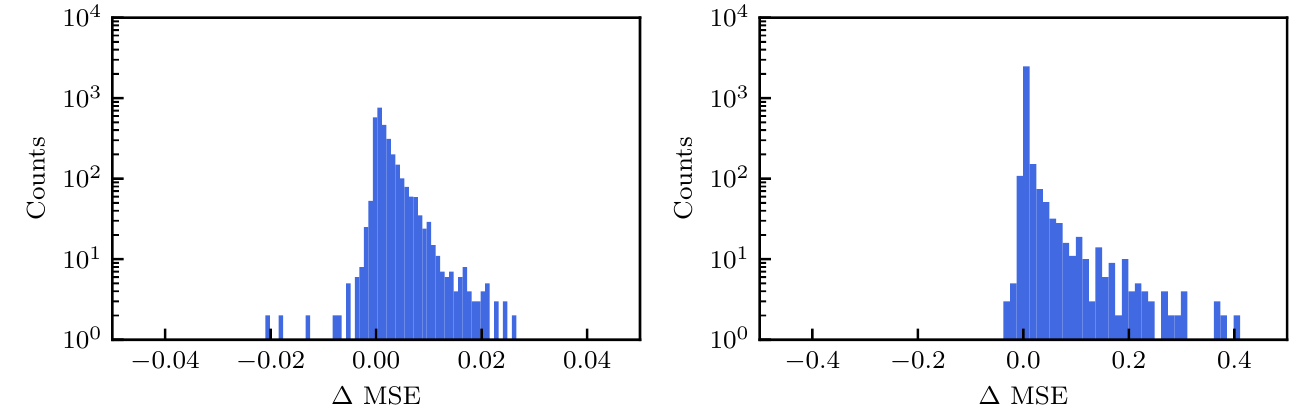
Figure 12. Left column: Distribution of the MSE for the fit of the DA model (14b) with three parameters (top), after applying a GP 50 times to the DA numerical data (middle), and difference of the MSE for the two approaches (bottom). Right column: Same, but for the model with two parameters. Note the difference in horizontal scale between the left and right plots.